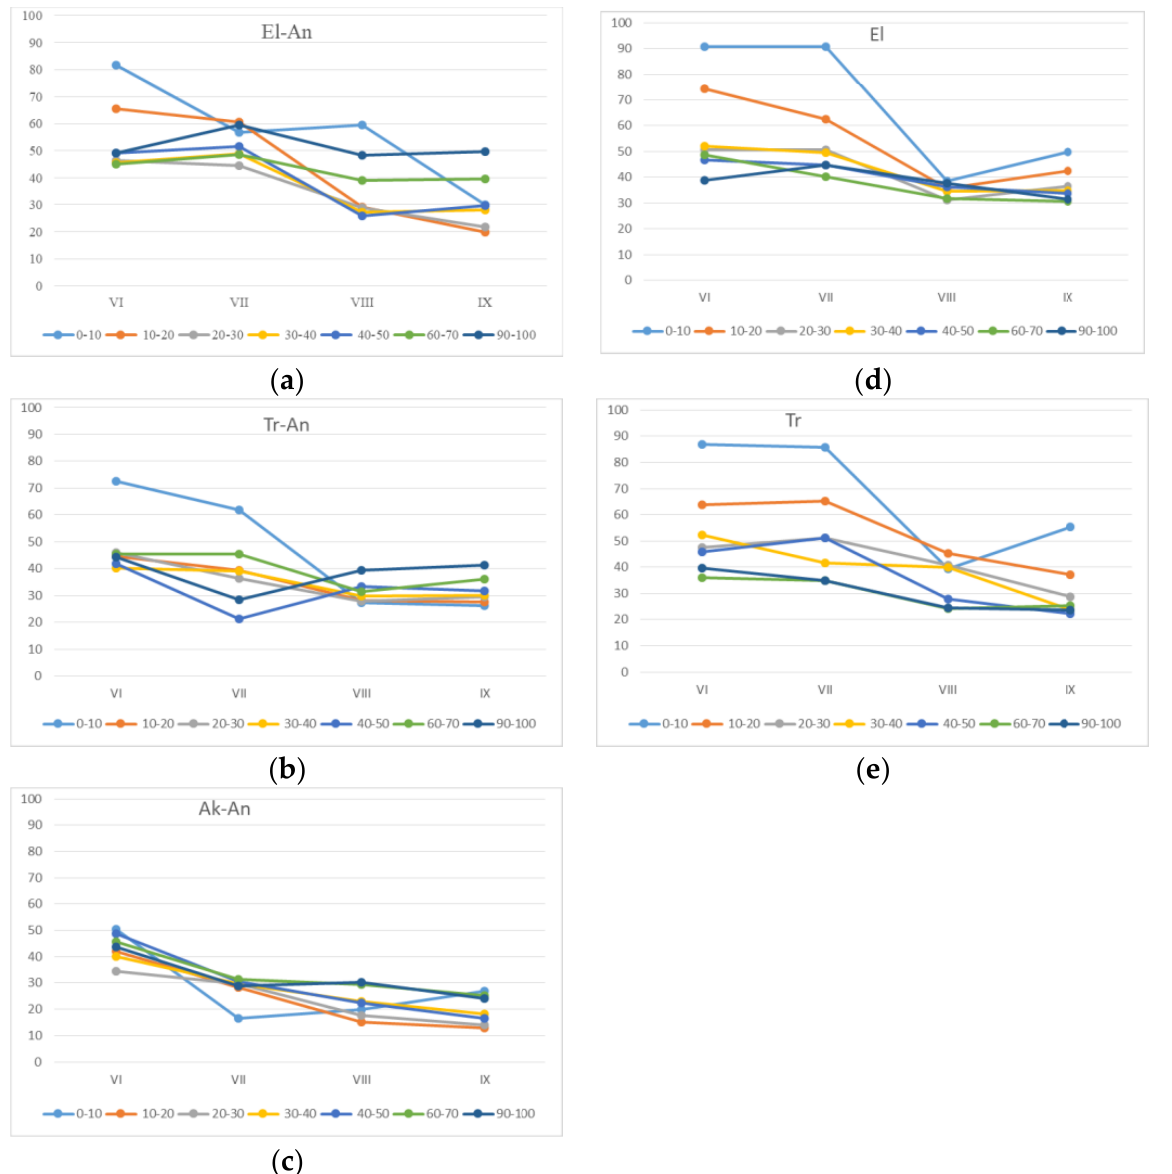
Figure 1. Moisture conditions of soils (%) at each 10 cm depth for topographical features of catena I, namely ( a ) El-An, ( b ) Tr-An, and ( c ) Ak-An, and for topographical features of catena II, namely ( d ) El, and ( e ) Tr. The Roman numerals refer to the month of observations.